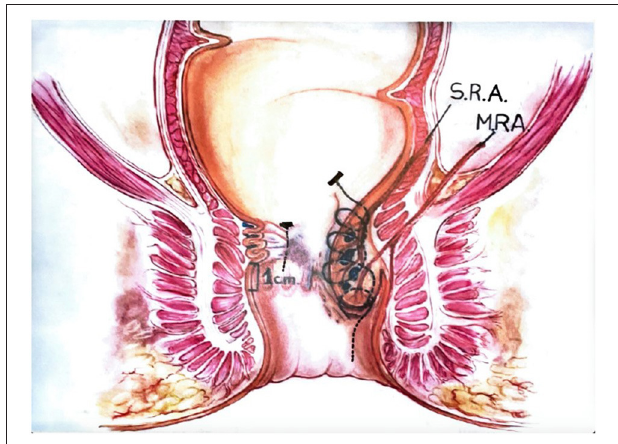
FIGURE 2 | Anolift diagram.